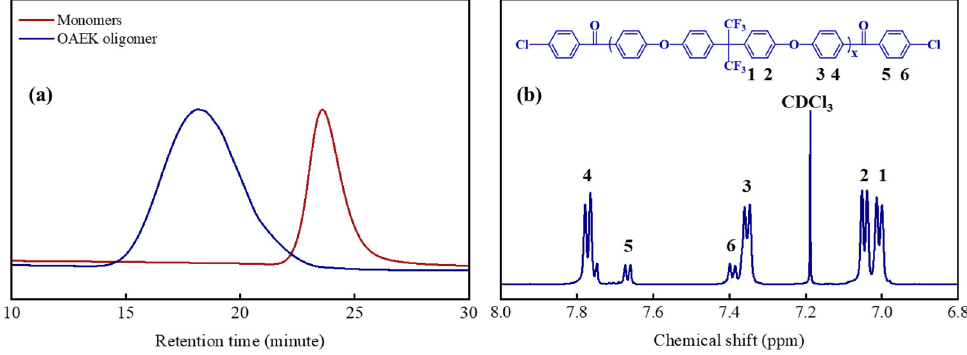
Figure 1. ( a ) Gel permeation chromatography (GPC) profile and ( b ) 1 H NMR spectra of the Cl-end-capped OAEK oligomer recorded in CDCl 3 .